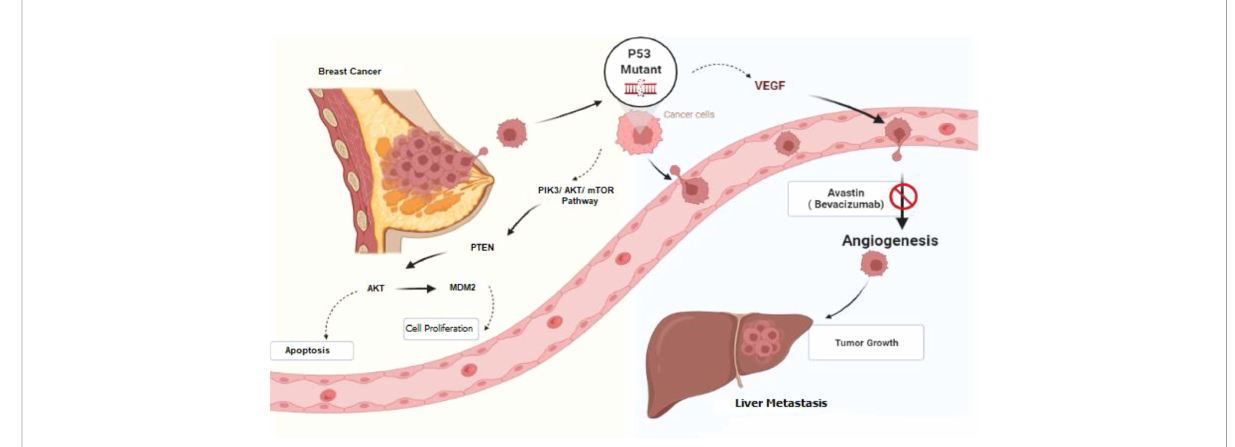
FIGURE 5 Schematic diagram of the signaling pathway from breast cancer to liver metastasis. TP53 protein is one of the important targets in the cancer signaling pathway and is involved in cell-cycle control, apoptosis, and angiogenesis. Bevacizumab is a VEGF-A monoclonal antibody against circulating VEGF and can inhibit tumor angiogenesis. This fi gure is created by